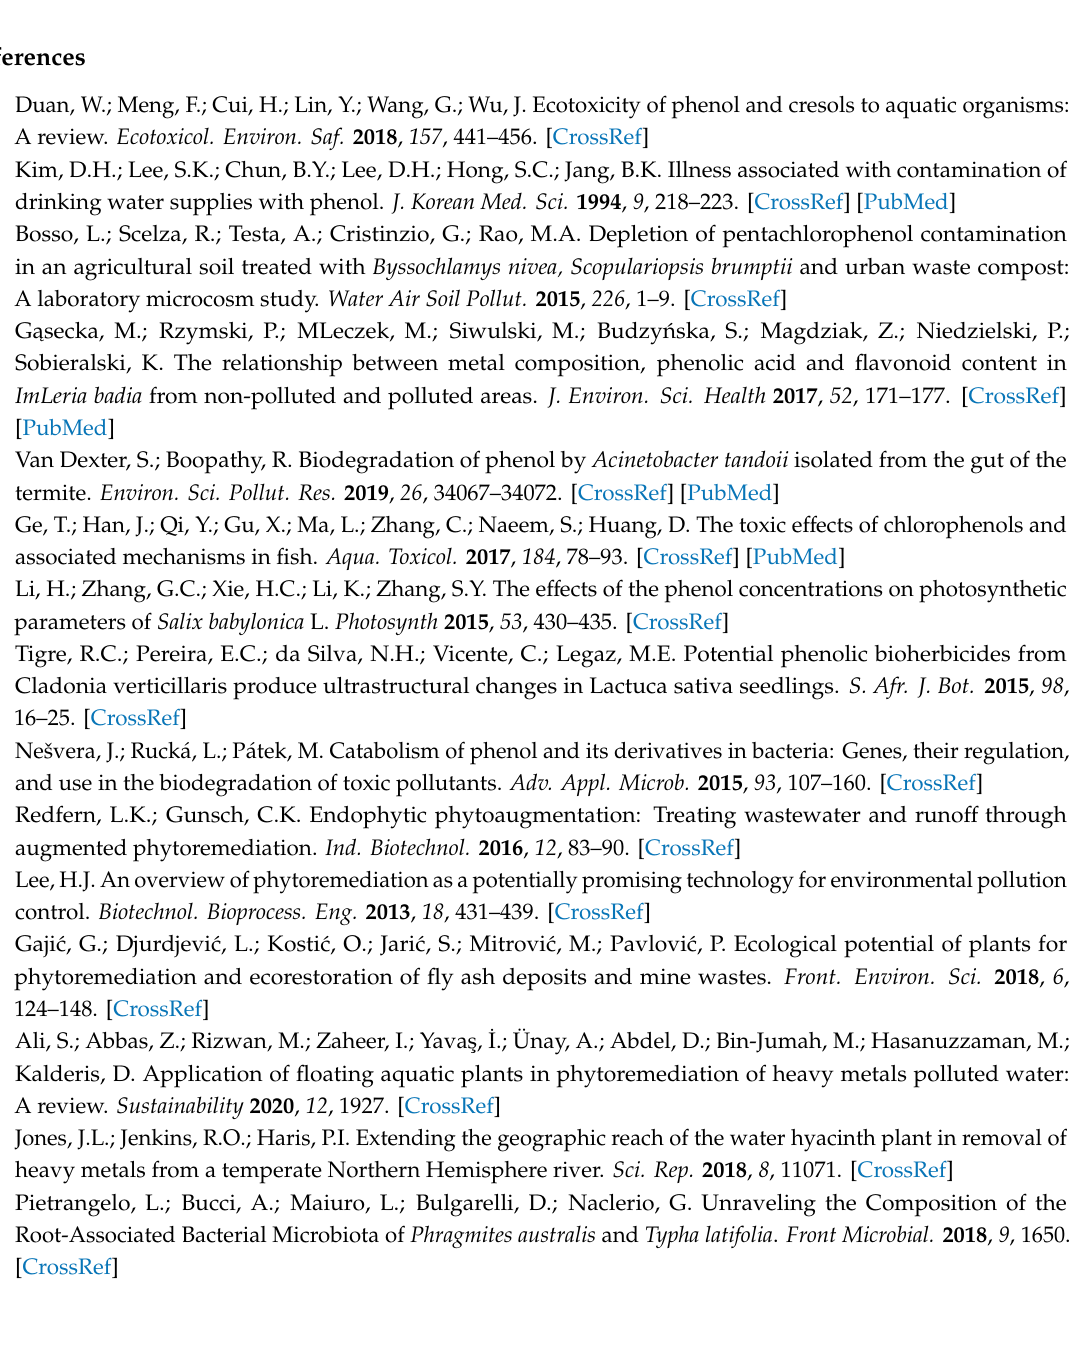
Figure S1: Flasks with bacterial strains and duckweed in MS nutrient medium after 14 days of cultivation, Table S1: Results of 16S rDNA sequencing for previously taxonomically undetermined bacterial strains (11 and 14) and of gyrB sequencing for Serratia sp. (27) and Serratia nematodiphila (51), and Table S2: MIC of